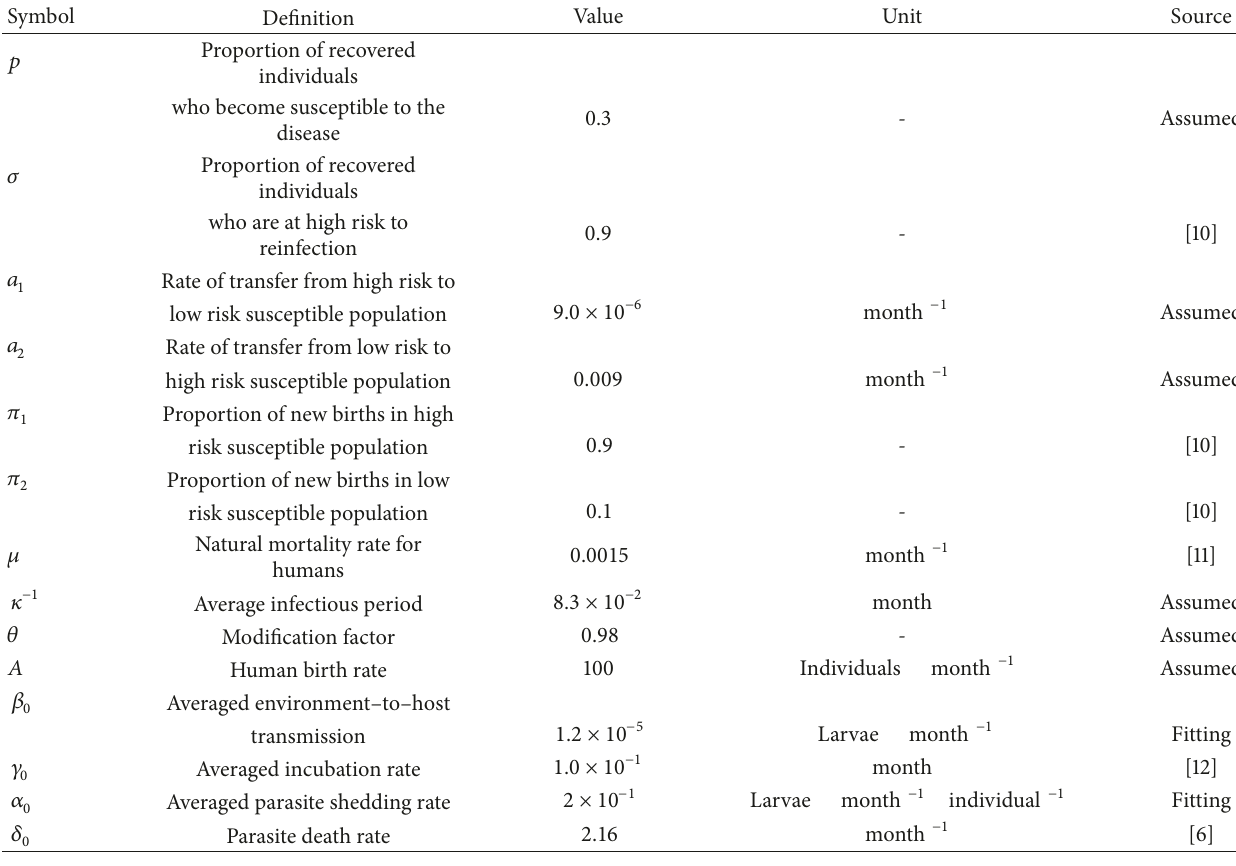
Table 1: Description of model parameters for system